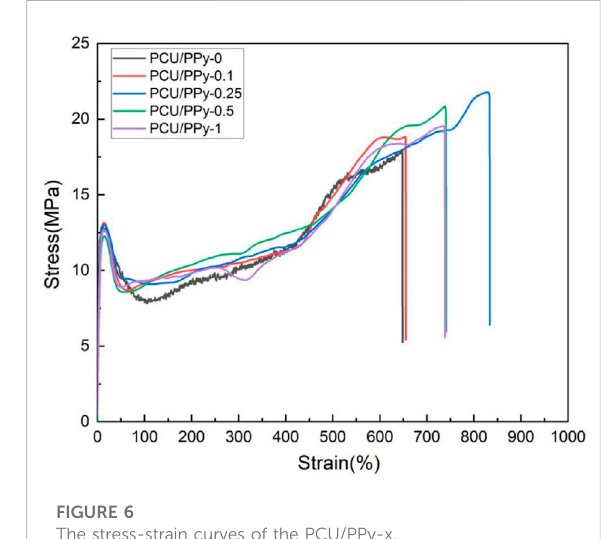
FIGURE 4 1 H NMR spectrum of PCU.